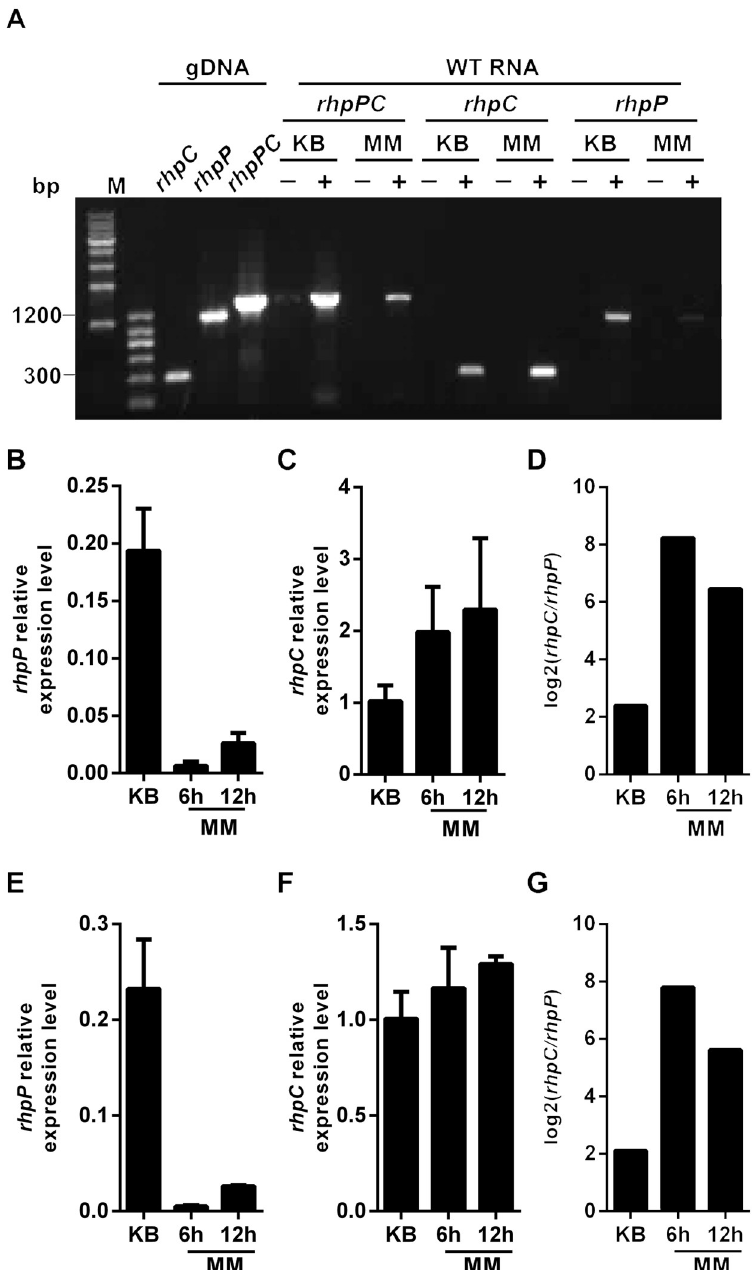
Fig 2. rhpP and rhpC are polycistronic and differentially expressed in KB and MM. (A) Total RNAs (2 μ g) extracted from Psph bacterial cells grown in KB and MM were reverse-transcribed with the primer corresponding to the 3’ end of rhpC . 10% of each reaction was used as template for PCR. Primers for PCRs were shown in S9 Fig. Bacterial genomic DNA (gDNA) was used as control to show the size of each PCR product. “+” and “-” indicated PCR templates from reactions with and without reverse transcriptase, respectively. 35 cycles were used for RT-PCR of rhpPC and rhpP , and 25 cycles were used for RT-PCR of rhpC . M indicates DNA molecular markers. (B-G) Real time PCR analyses of rhpP and rhpC RNA expression in Psph bacterium grown in KB and MM. Total RNAs were reverse- transcribed using random primers. The reactions were first treated with RNase and then used as template for real-time PCR analyses. The relative expression levels of rhpP and rhpC were normalized to 16S rRNA (B-C) and rpoD (E-F) transcripts, respectively. (D) and (G) show the ratio of rhpC / rhpP RNAs in each